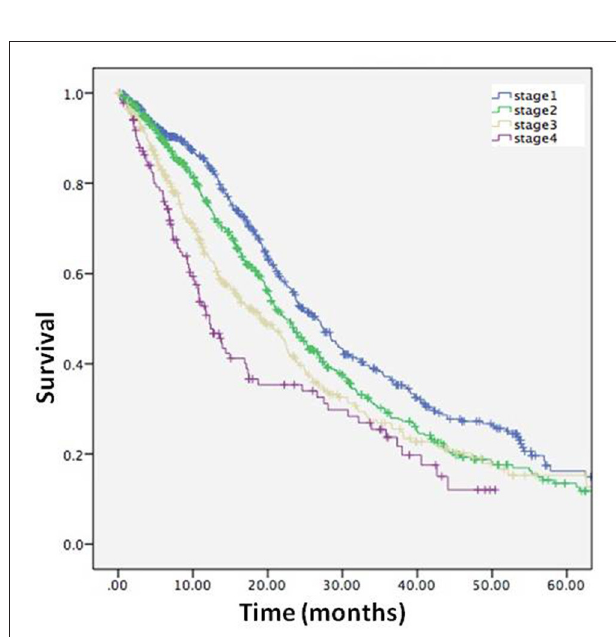
FIGURE 5 | Kaplan-Meier curve describing survival for entire cohort from each stage to death or